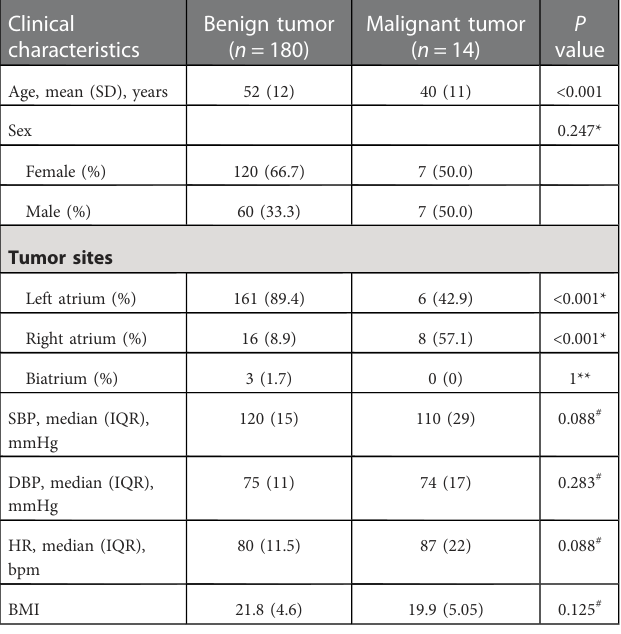
TABLE 1 comparison of clinical characteristics between patients with primary atrial benign tumors and primary atrial malignant tumors. Clinical characteristics